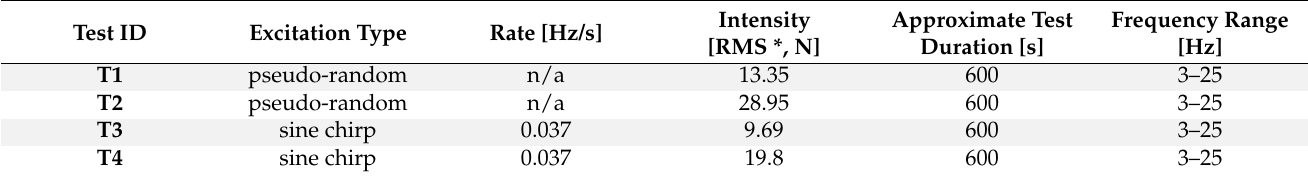
Table 1. Summary of the conducted modal